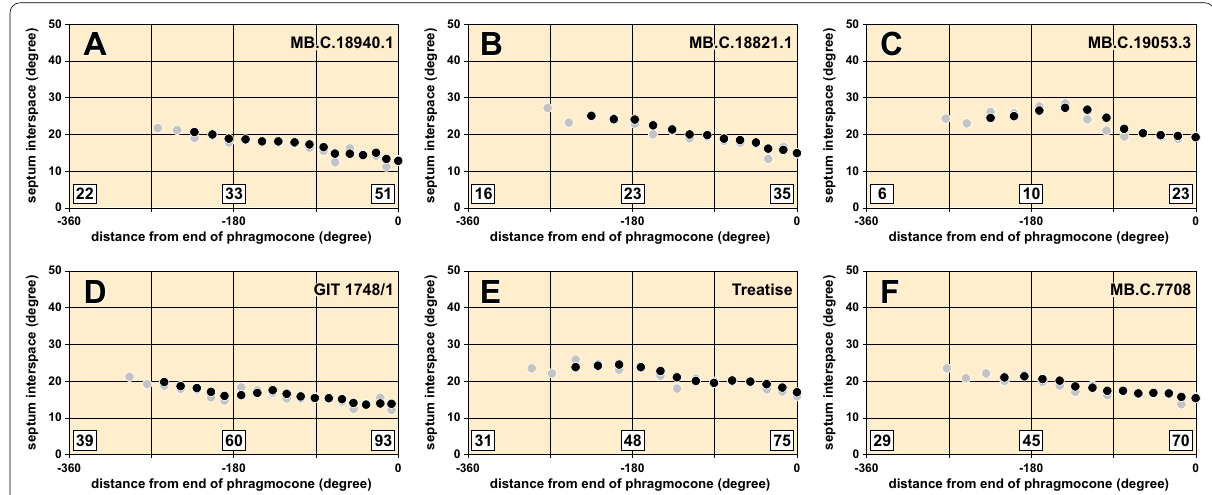
Fig. 11 Ontogenetic trajectories of septal distances in six representatives of the Late Tournaisian Imitoceras . Respective phragmocone diameters (in mm) in the bottom boxes. A – C Imitoceras dimideum Korn, Bockwinkel & Ebbighausen, 2010a from Oued Temertasset. D – F Imitoceras ixion (Hall, 1860) from Rockford (Indiana) (11E after Miller et al., 1957)